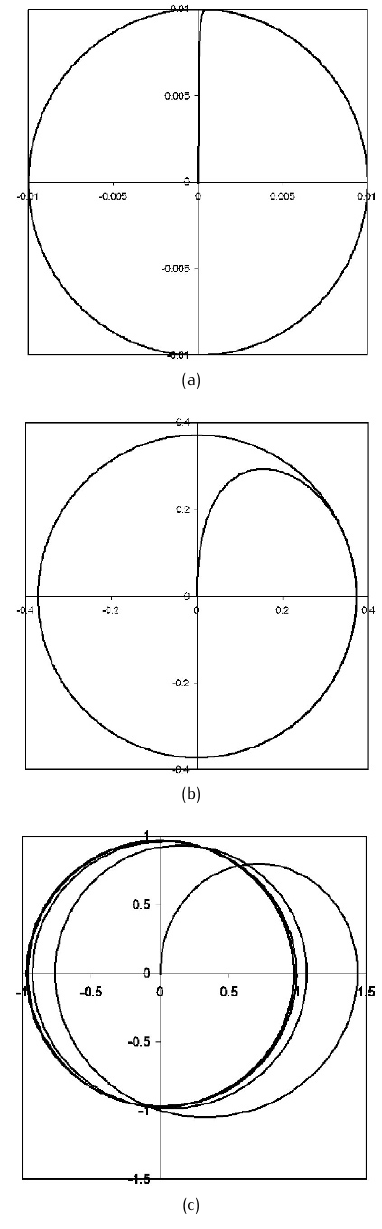
Figure 3. Phase diagrams: (a) ωt d = 0 . 01 ; (b) ωt d = 0 . 4 ; (c) ωt d = 4